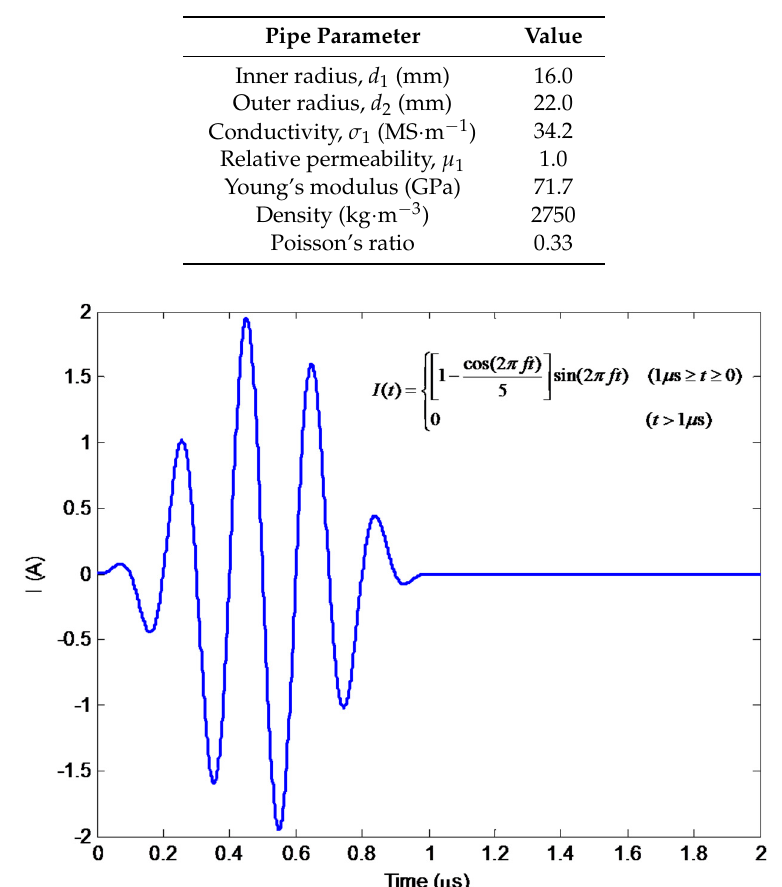
Figure 5. The excitation current with the excitation frequency of 5 MHz for driving the proposed transducer.